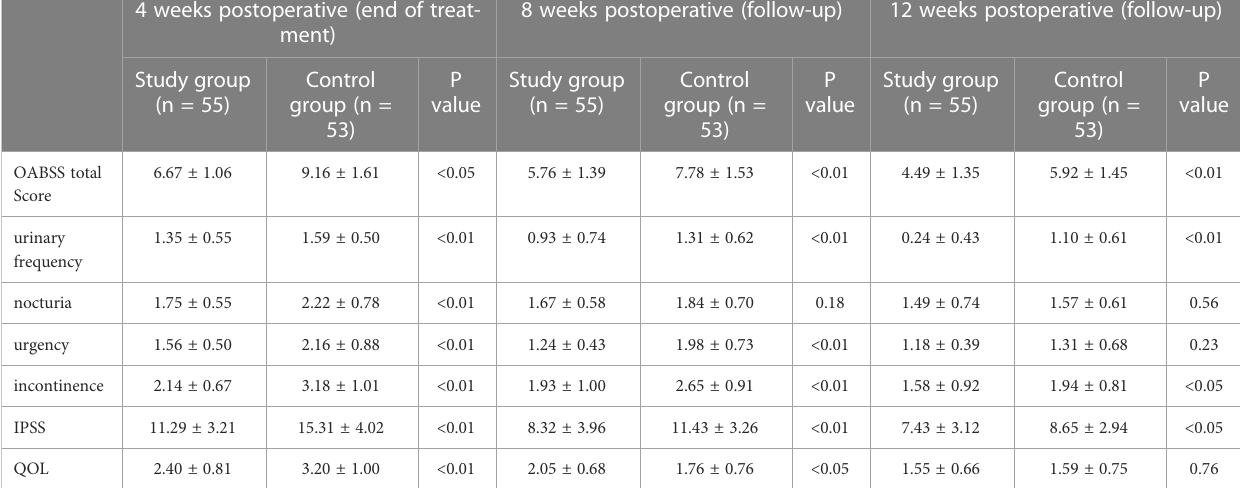
TABLE 2 The comparison of OABSS scores, IPSS scores, and QOL scores during drug treatment and follow-up. 4 weeks postoperative (end of treat- ment)